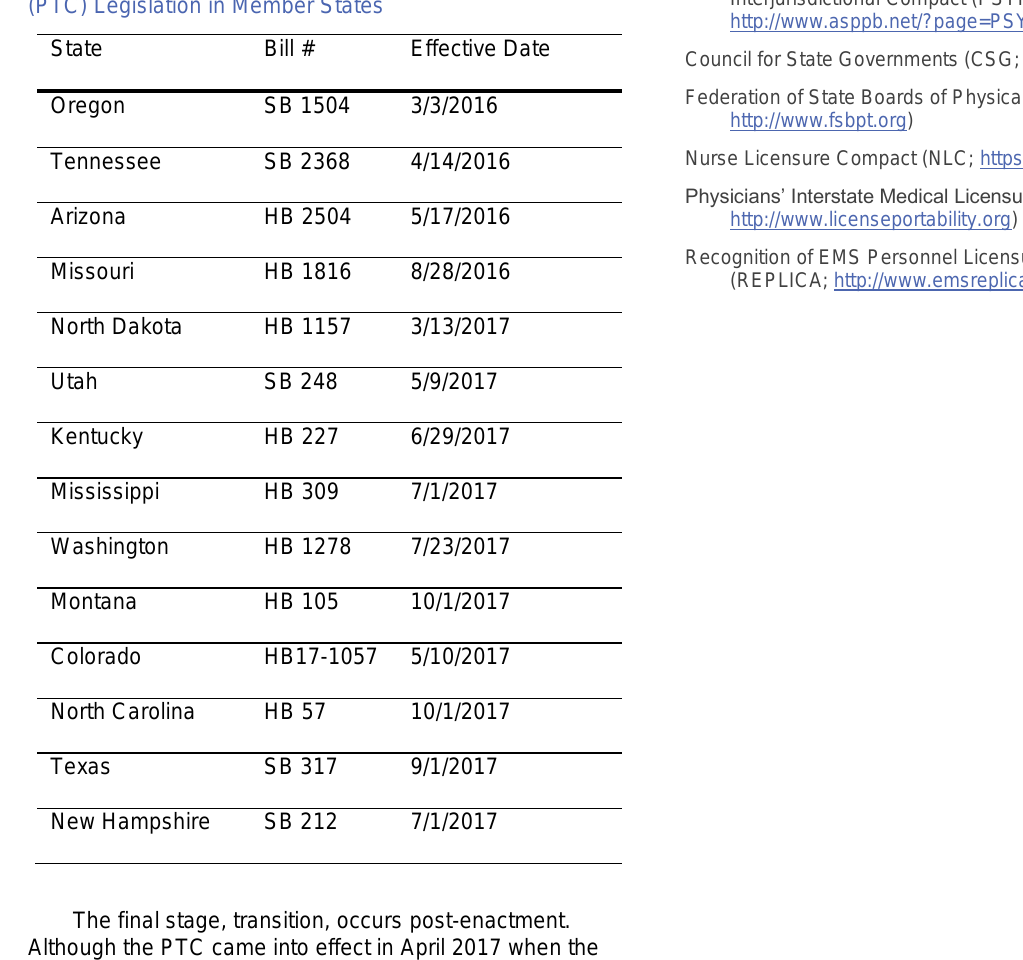
Table 1. Effective Dates of Physical Therapy Compact (PTC) Legislation in Member